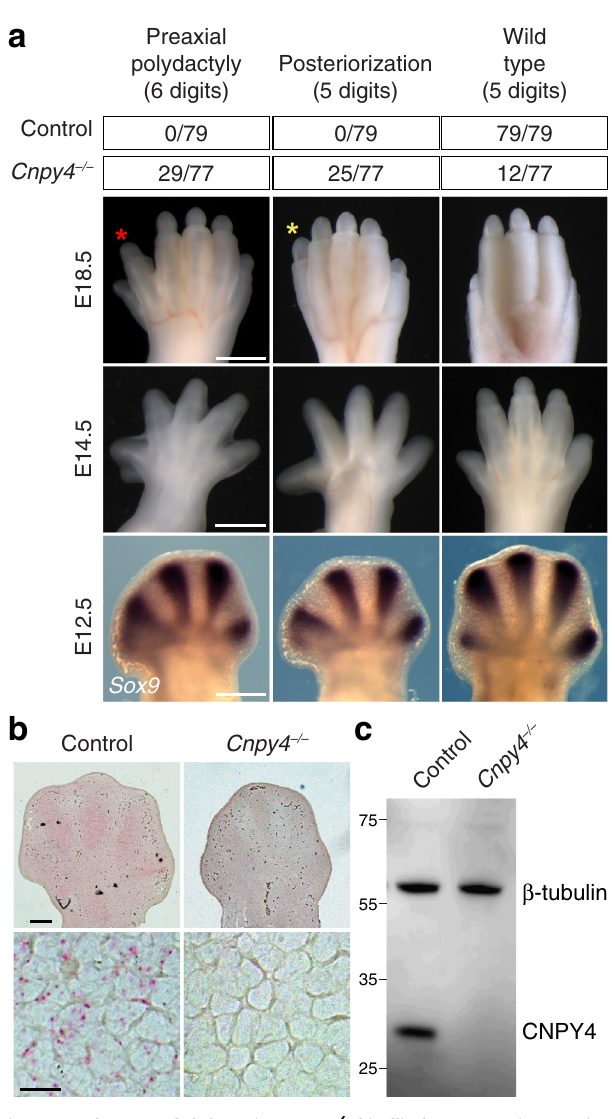
Fig. 1 Developmental defects in Cnpy4 – / – hindlimbs. a Dorsal view of control and Cnpy4 mutant hindlimbs at embryonic day (E)18.5 (top row) and E14.5 (middle row). The majority of Cnpy4 mutant hindlimbs exhibit either an extra digit anteriorly (red asterisk) or a transformation of digit 1 from biphalangeal to triphalangeal (yellow asterisk). Whole mount in situ hybridization for Sox9 at E12.5 (bottom row) indicates an extra digit and an enlarged digit 1 primordium. The top table summarizes the phenotype frequency in mutant hindlimbs; less frequent phenotypes are shown in Supplementary Fig. 1a, b. The scale bars represent 500 μ m. b Single molecule in situ hybridization (RNAscope) of Cnpy4 in the hindlimbs of control and Cnpy4 mutant embryos at E12.5. The scale bars represent 200 μ m (top) and 40 μ m (bottom). c Protein levels in lysates of MEF cells from control and mutant embryos were detected using the indicated antibodies by Western blot analysis. All experiments were performed three independent times with similar